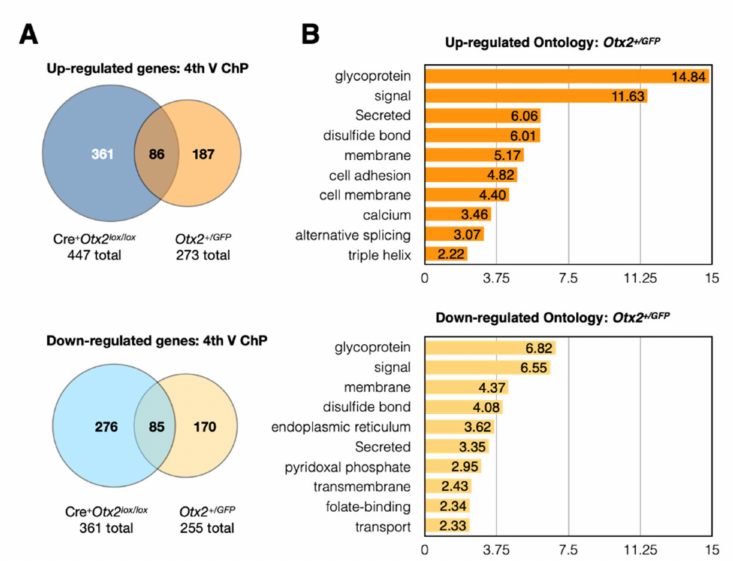
Figure 2. Gene expression in choroid plexus of Otx2 +/GFP mice. ( A ) Venn diagrams of the number of up- or down-regulated genes ( p-adj < 0.05) to compare overlap between fourth ventricle (4th V ChP) changes in Otx2 +/GFP mice and in Cre-Tat icv-injected Otx2 lox/lox mice (Cre + Otx2 lox/lox ); ( B ) Ontology analysis of differentially regulated genes in Otx2 +/GFP